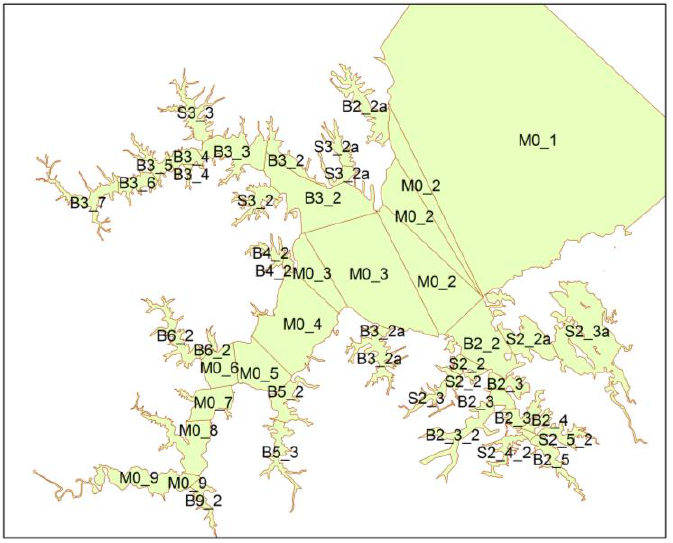
Figure 6. Segmentation and tidal prism model of Poquoson River.